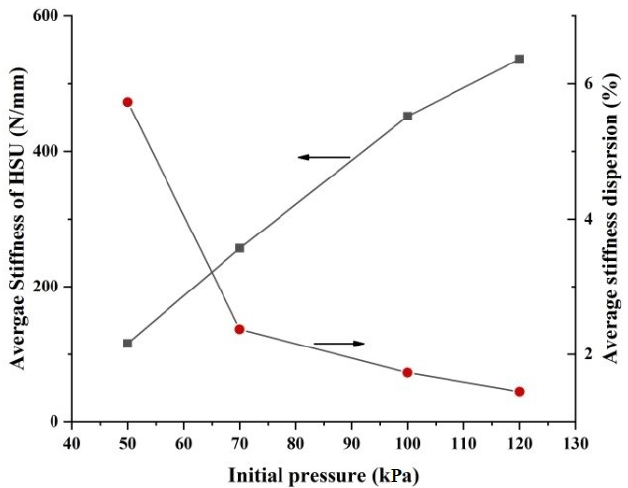
Figure 11. Average stiffness and stiffness dispersion of HSUs versus various initial pressure values. For 3 HSUs for stiffness tests under 100 kPa, each HSU can be measured under indenter pressing speeds of 0.1 mm/min, 0.2 mm/min, 0.3 mm/min, 0.4 mm/min and 0.5 mm/min,